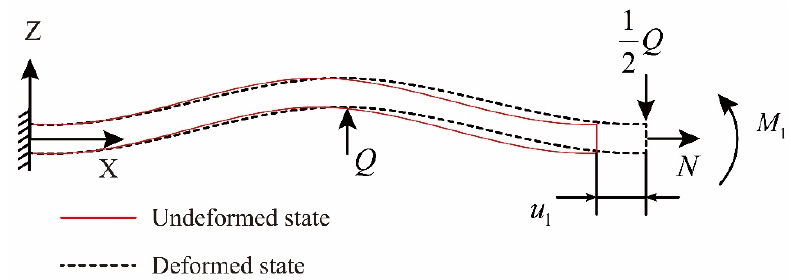
Figure 6. X-directional deformation of the deformed warp yarn segment.